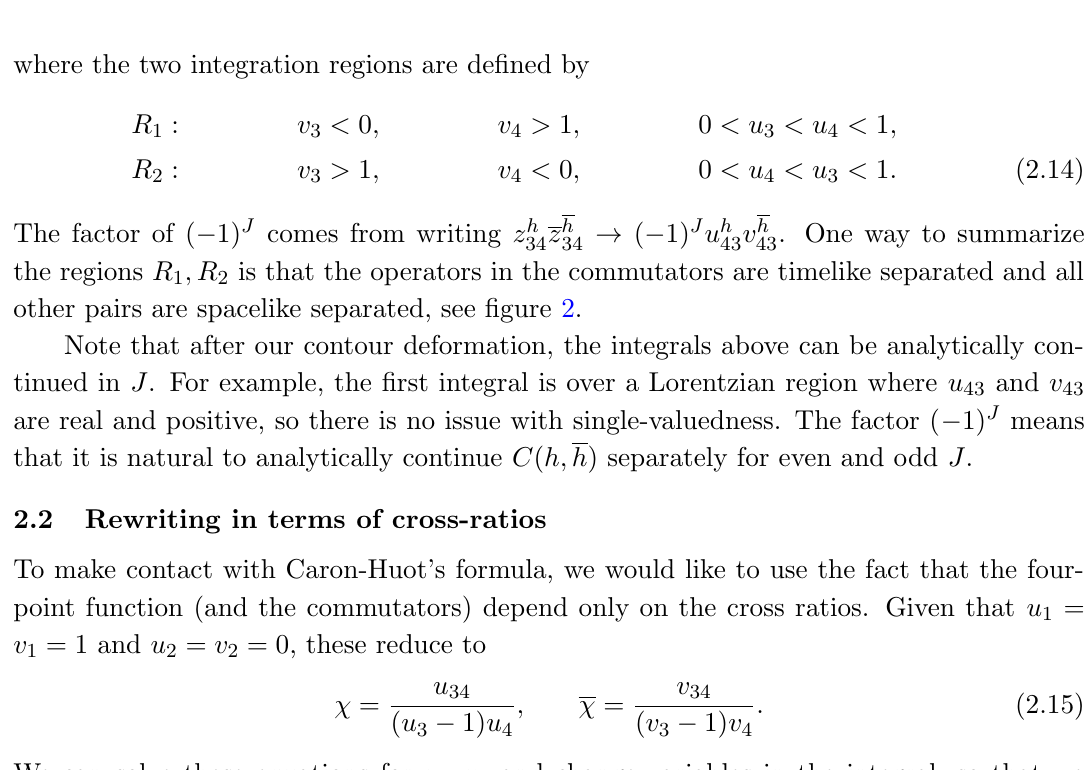
Figure 2 . We show typical con(cid:12)gurations for points 3 and 4 within regions R 1 and R 2 . The dotted line is not (cid:12)xed in place, it is only to emphasize that points 3 and 4 must be spacelike separated. Time goes